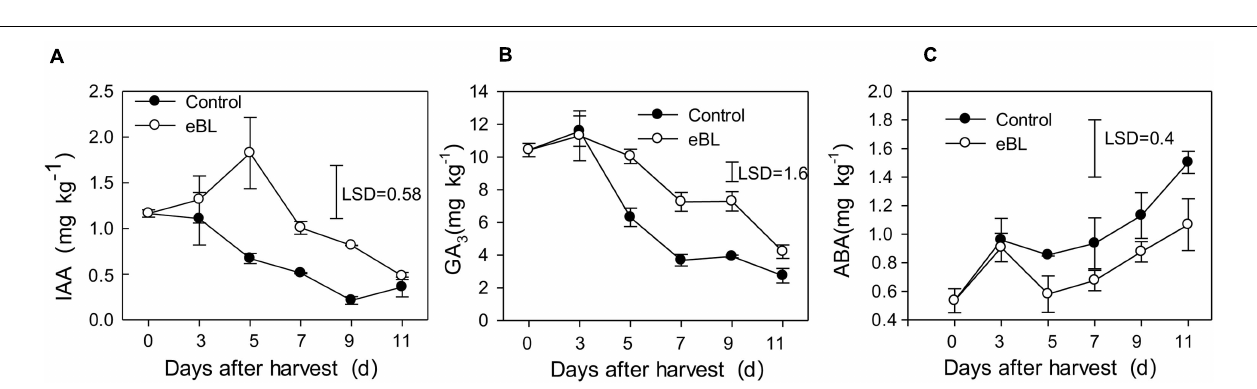
FIGURE 5 | Effects of eBL treatment on the activities of respiration-related enzymes. (A) The content of 6-P-F; (B) SDH activity; (C) CCO activity; (D) the total activities of G-6-PDH + 6-PGDH. Least significant differences (LSDs) were calculated to compare significant effects at the 5% level. Each data point represents the mean ± S.E. ( n = 3).